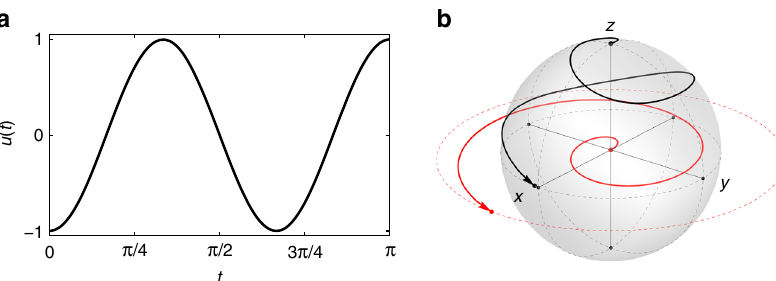
Fig. 1 Exact excitation of single spins. a The minimum-energy control u * π /2 steering the spring from X 0 = (0,0) to X π /2 = ( π /2,0), with b the corresponding trajectories of the spring ( red ) and spin ( black ) for ω = 3 and T =